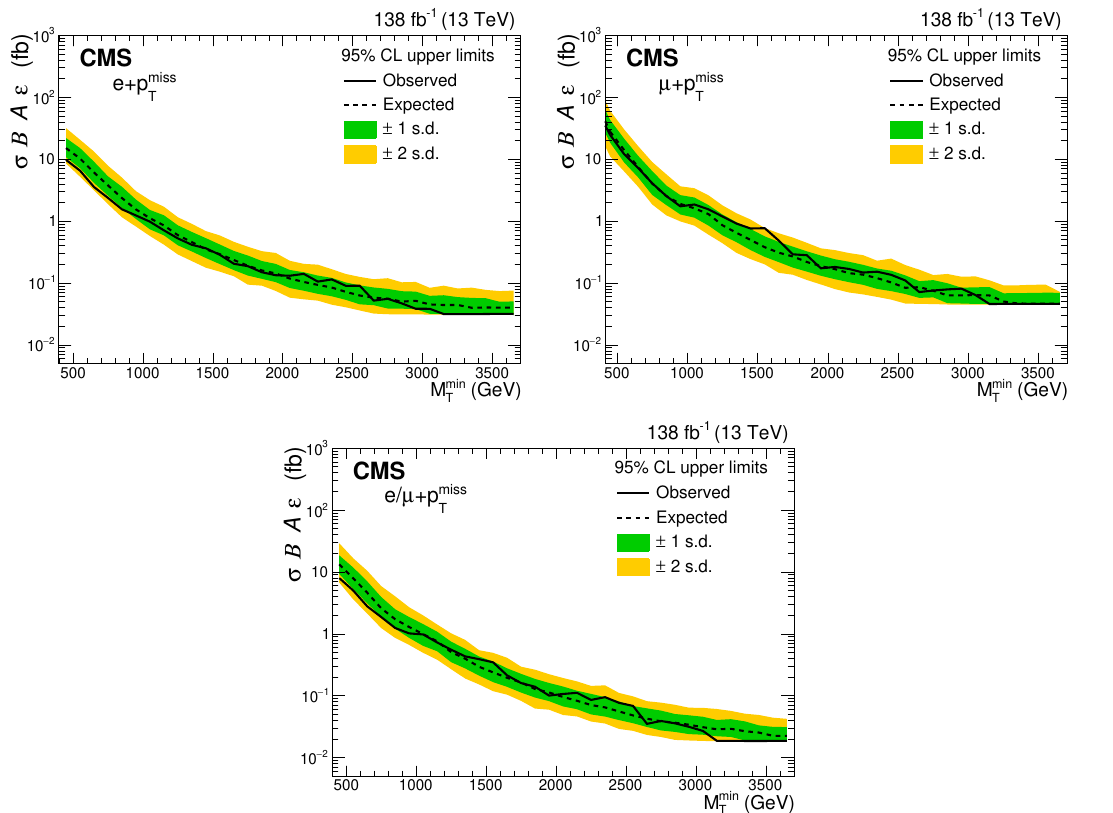
Figure 6 . The 95% CL observed (solid line) and expected (dashed line) model-independent cross section limits as functions of the M min threshold. These are shown for the electron (upper left) and T muon (upper right) channels and their combination (lower). The one and two standard deviation uncertainty bands for the expected limits are shown.